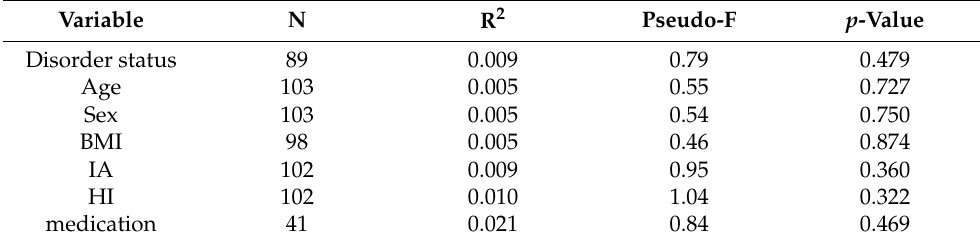
Figure 1. Boxplot of multivariate homogeneity of groups’ dispersions (betadisper) of participants with ADHD and controls. Box plots represent median with whiskers on ±1.5 IQR. Pseudo-F = 3.051, p = 0.08. Table 2. Beta diversity analysis.